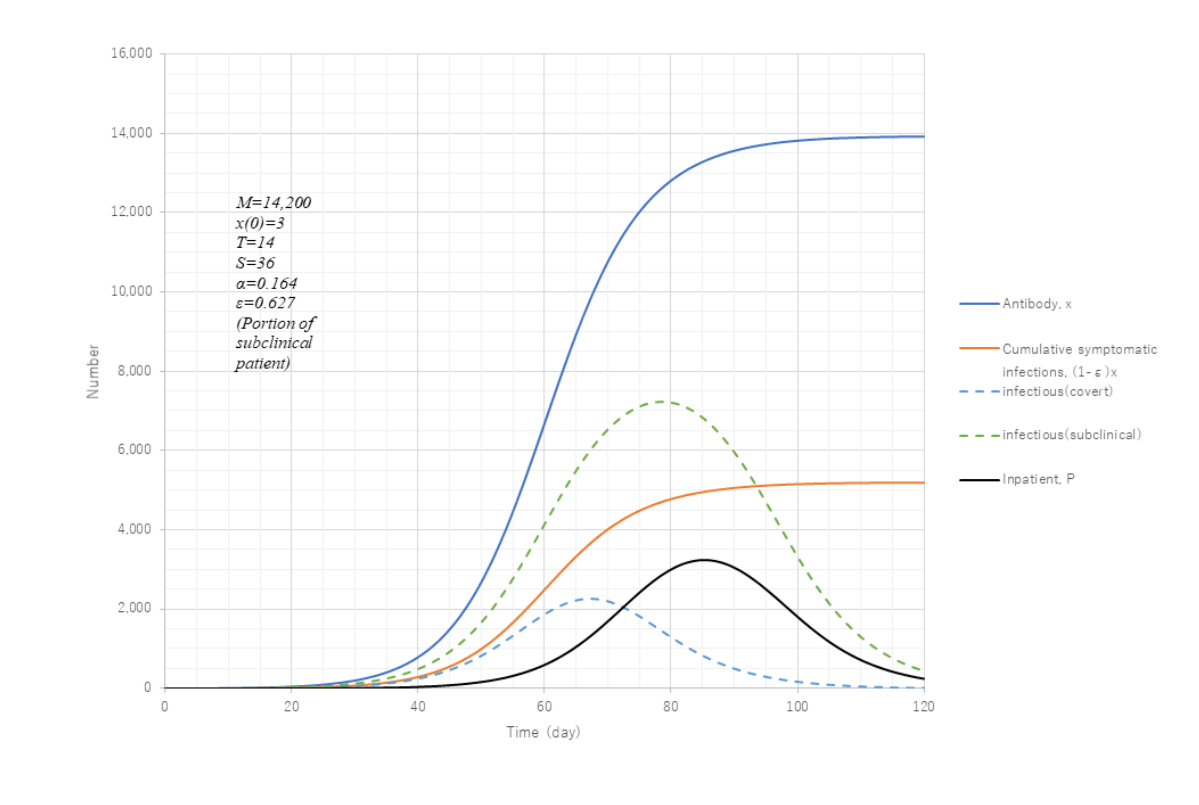
Figure 8. Model calculation with subclinical patients considered. Model PART2 (equation 1) was used. Model parameter M was determined to be 14,200 with the aid of the antibody prevalence test results. Parameter ε was optimized so as to give cumulative symptomatic infections, (1- ε )x is the same as that computed by PART1. The remaining parameter values of x(0), T , S , and α were the same as PART1. Broken lines represent infectious cases as covert and subclinical